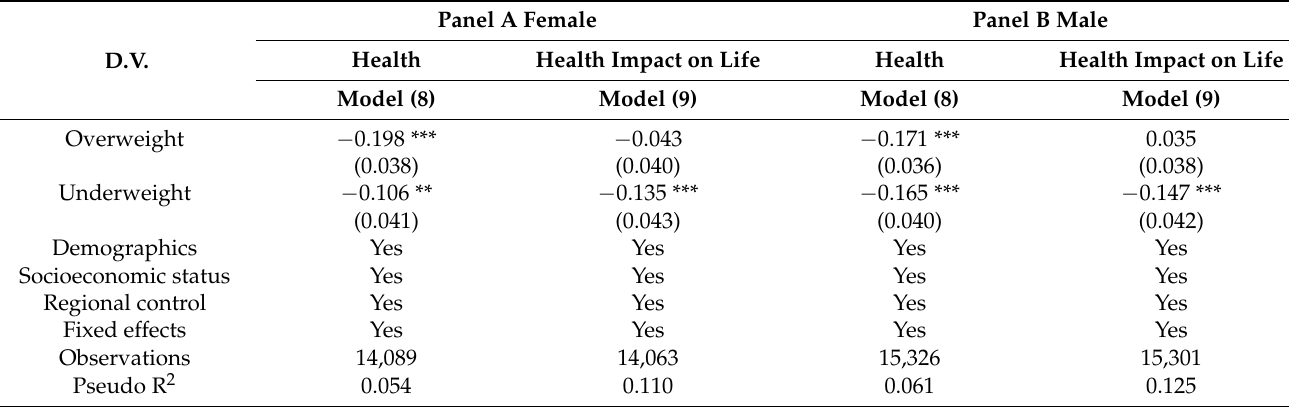
Table 6. Ordered logit results of body shape impact on health status.